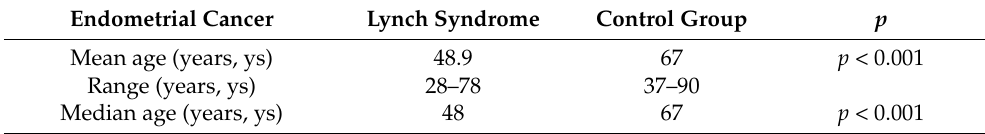
Table 1. Age at diagnosis of endometrial cancer for LS patients and the control group. Endometrial Cancer Lynch Syndrome Control Group p Mean age (years, ys) 48.9